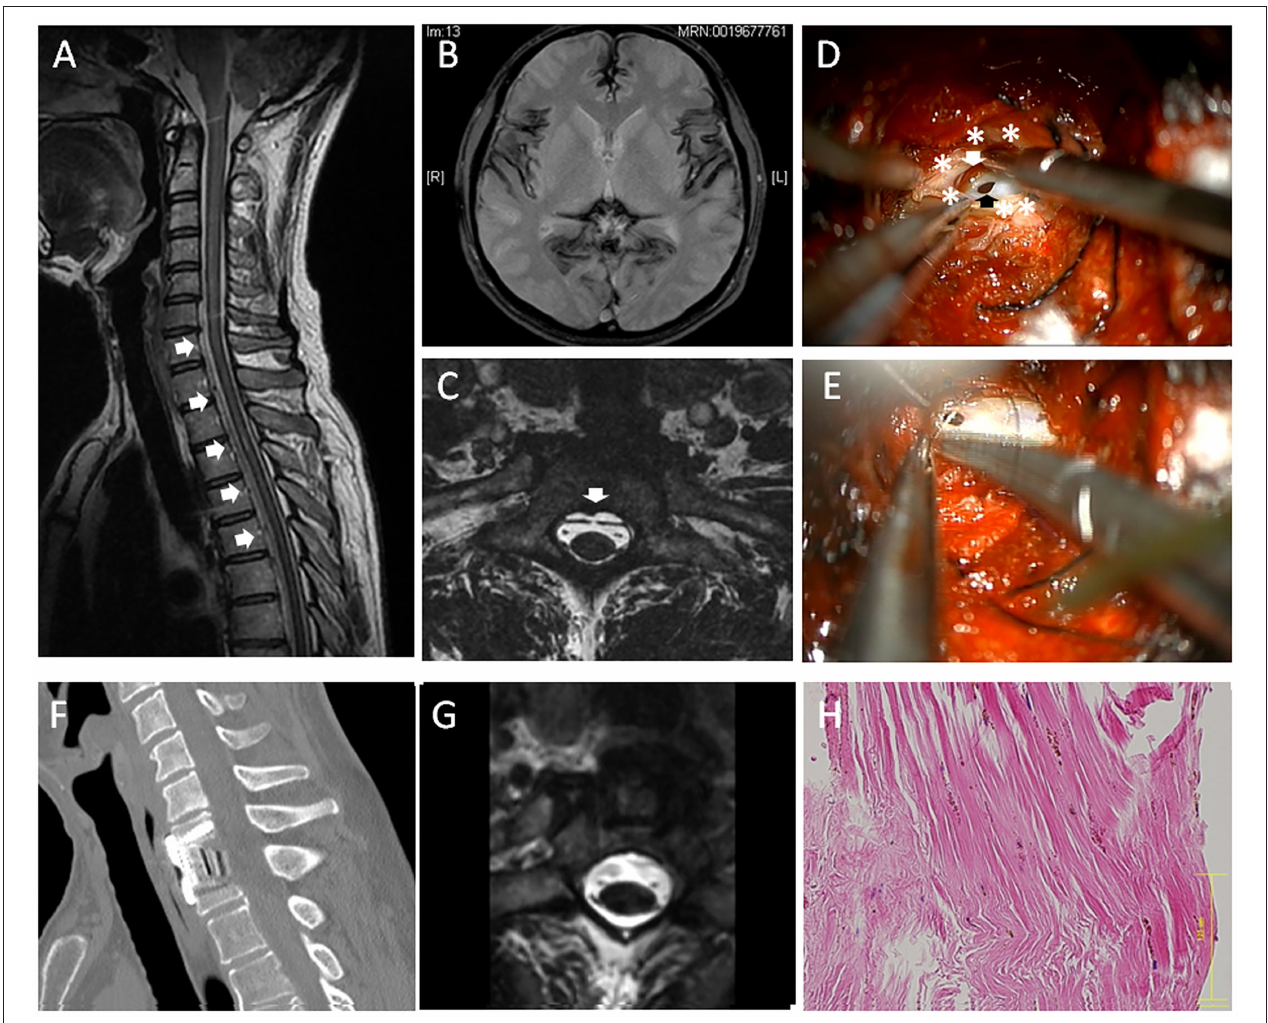
FIGURE 1 | A 51-year-old male (case 1). (A) Sagittal magnetic resonance imaging (MRI) showed ventral fluid-filled collection in the spinal canal (VFCC) (white arrows) from C5 to T7. (B) Brain MRI showed a T2-weighted hypointensity in the superficial brain. (C) A fast imaging employing steady-state acquisition (FIESTA) image demonstrated a dural defect at the C7-T1 level (the white arrow). (D) An intraoperative picture of anterior approach (case 1): After the outer dura layer (white asterisks) was cut longitudinally, we found a dural defect (the black arrow) in the dura mater’s inner layer. A bleeding clot was recognized between the inner and outer dural layers (the white arrow). (E) The dural defect was sutured using a 7-0 nylon. (F) The spine was reconstructed using a cage and a plate. (G) Post-operative MRI showed the dural defect was successfully repaired. (H) The outer layer of the dura was histologically examined using hematoxylin-eosin (HE) staining, showing